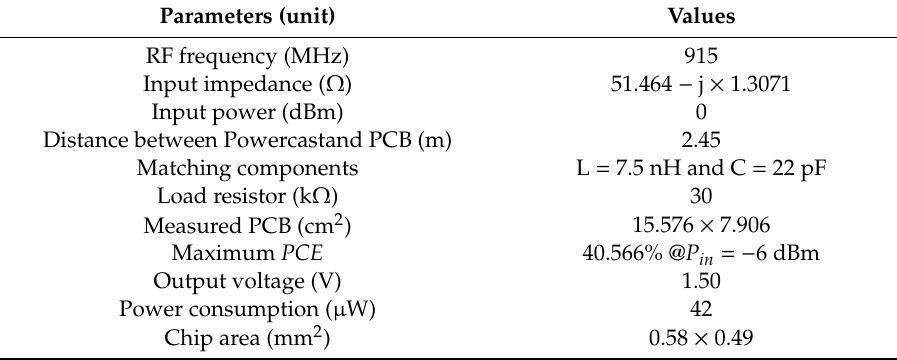
Table 4. Measured electrical characterizations of the proposed RF-energy-harvesting IC.